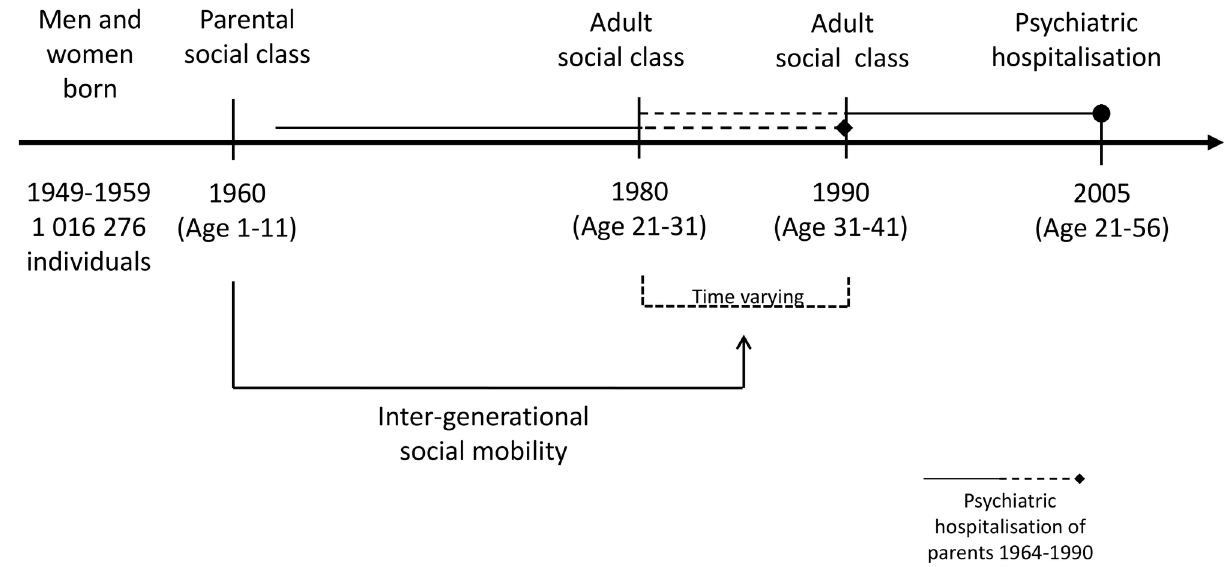
Figure 1. Overview of the time-points at which information for the studied subjects and their parents has been